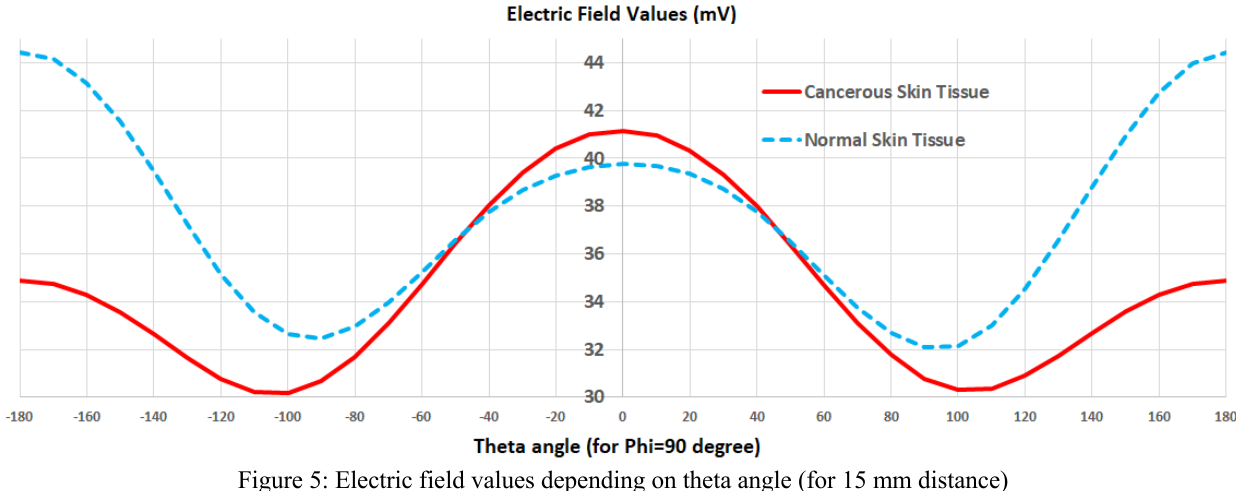
Figure 5: Electric field values depending on theta angle (for 15 mm distance)